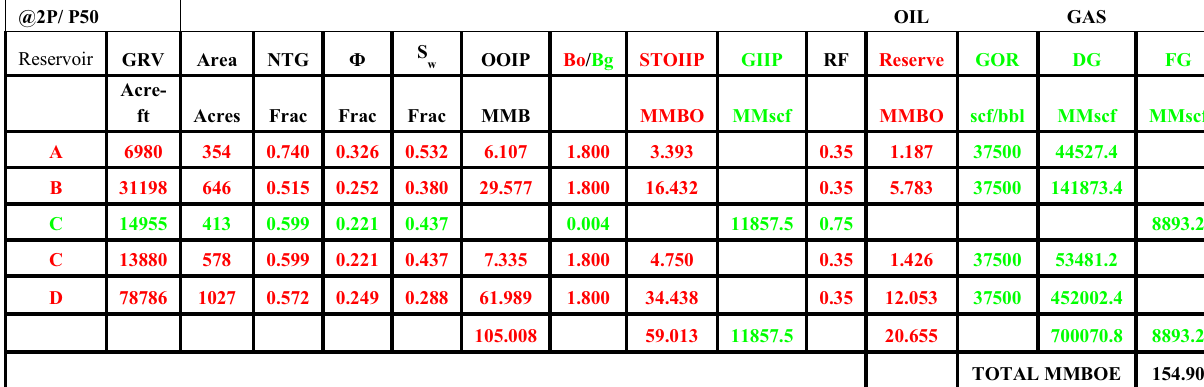
Table 3 Proven Reserve Resources Estimate at 2-P/P50 for ROI 1